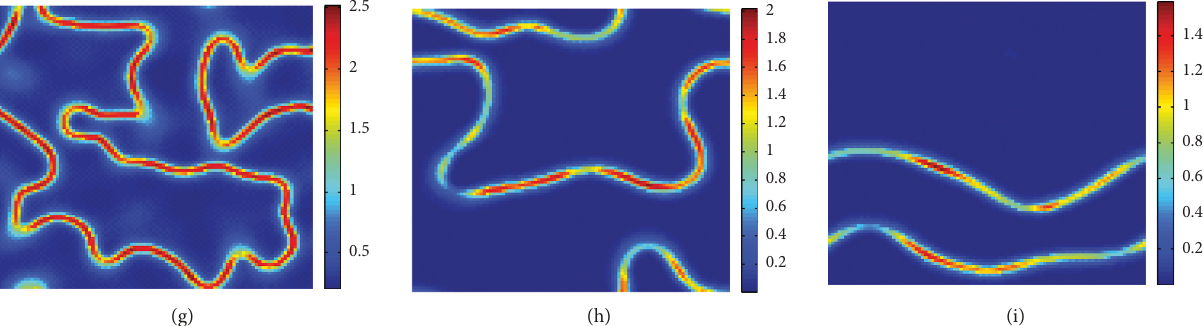
Figure 8: The formation of phytoplankton population spatial distribution pattern under certain diffusion parameters. Parameter values: I � 1 . 6, a � 0 . 5, b � 0 . 8, α � 0 . 7, e � 0 . 2, m � 0 . 45, d (d) t � 35; (e) t � 50; (f) t � 75; (g) t � 100; (h) t � 300; (i) t � 500.